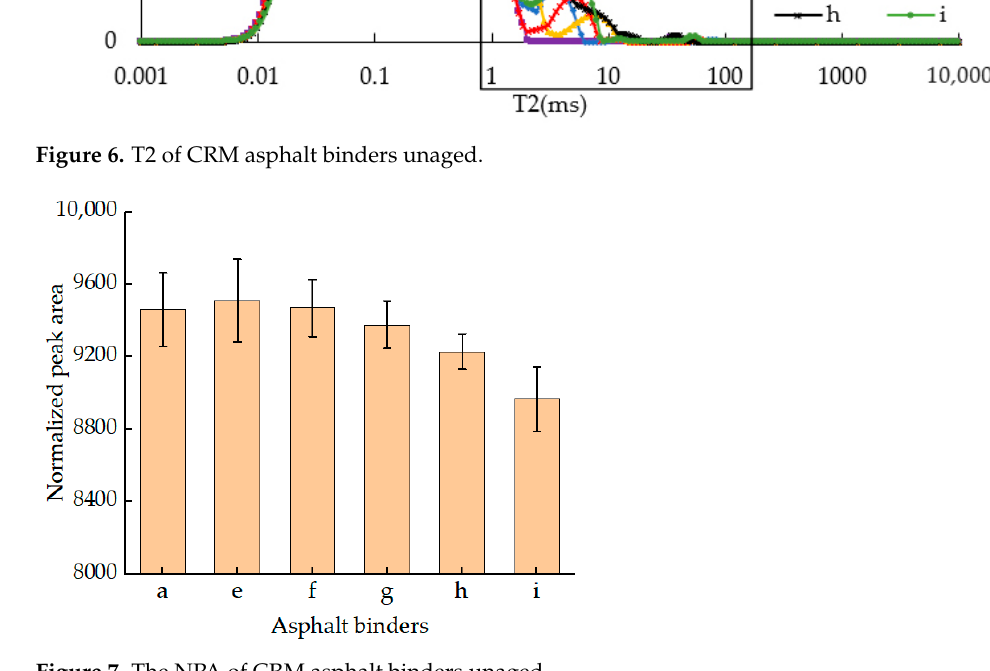
Figure 6. T2 of CRM asphalt binders unaged.